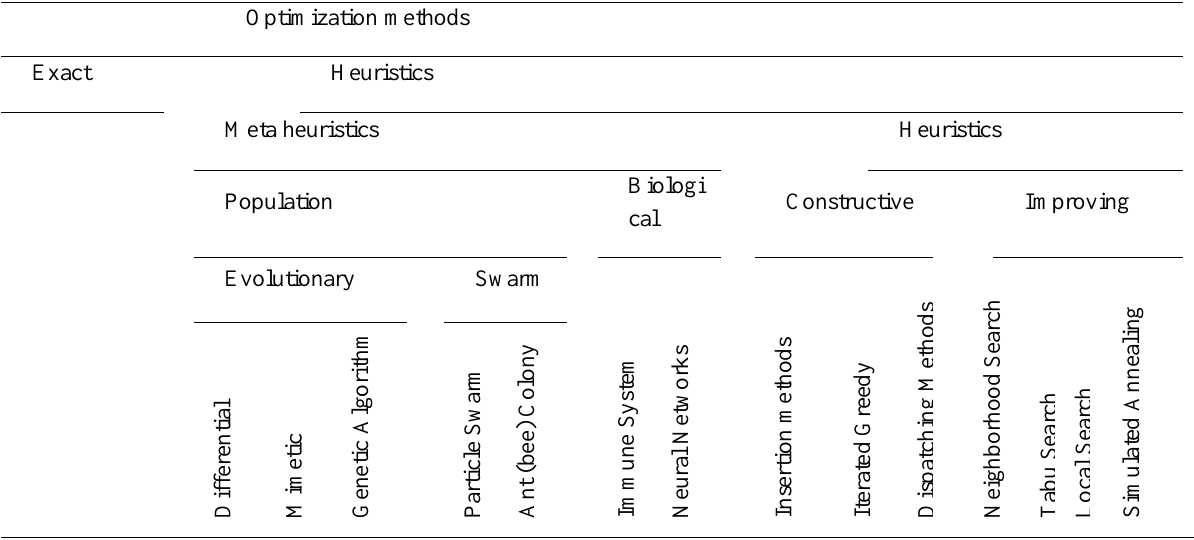
Table 2. A Hierarchical Presentation of the Solution Methods for the